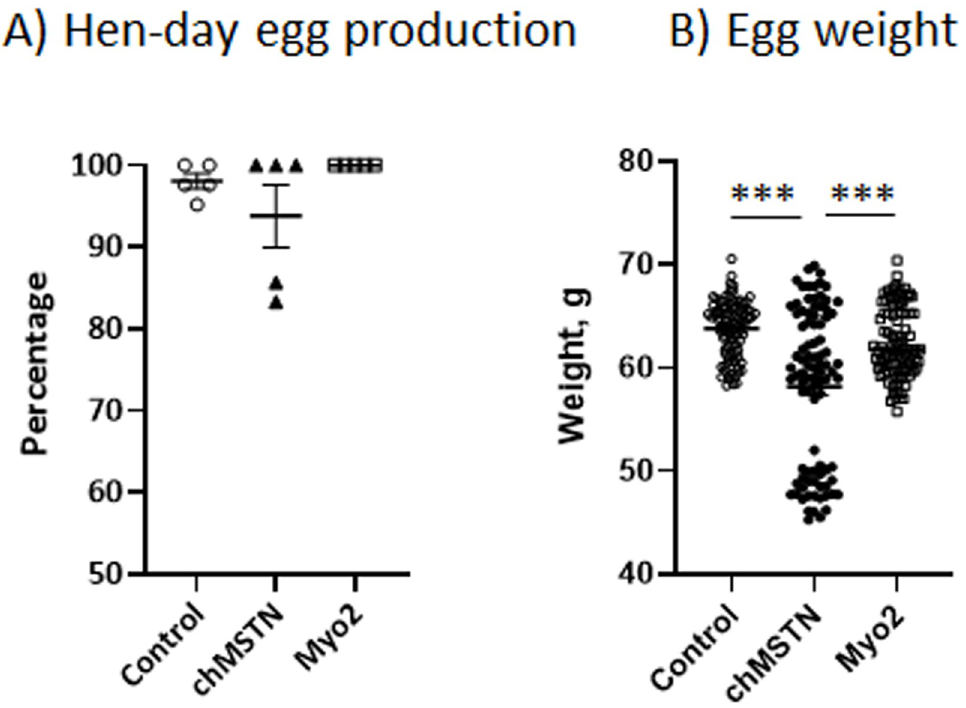
Fig 8. Hen-day egg production (A) and egg weight (B) in Experiment 2. Hen day egg production was calculated by dividing the number of eggs produced within a week by the average number of hens on hand for the same time interval during the 5 weeks. Data were analyzed by one-way ANOVA. Means were compared by Tukey’s-HSD test. ��� , P <